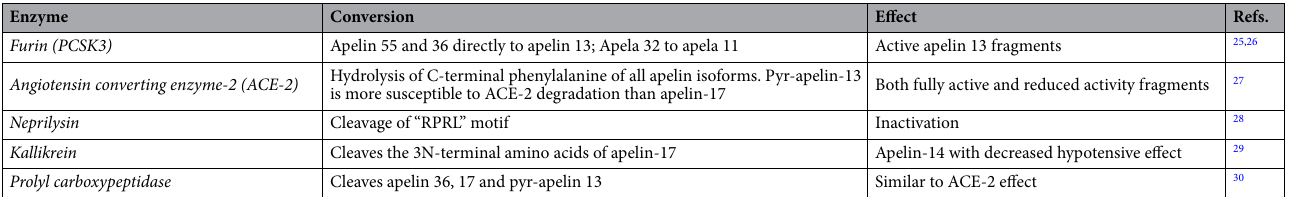
Table 1. Enzymatic processing of apelin. Other, yet unidentified enzymatic processes are most likely involved.